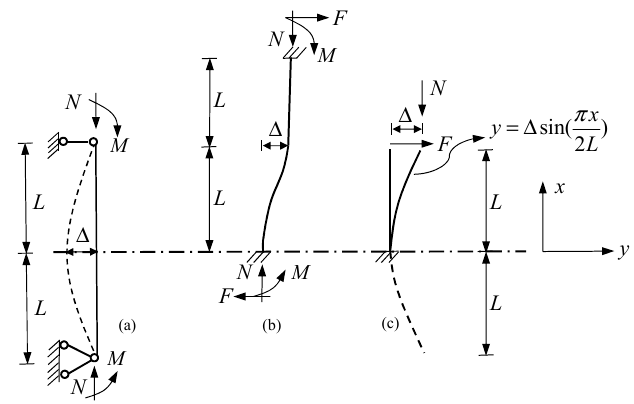
Figure 3. Mechanical models of the UHPCFST members.